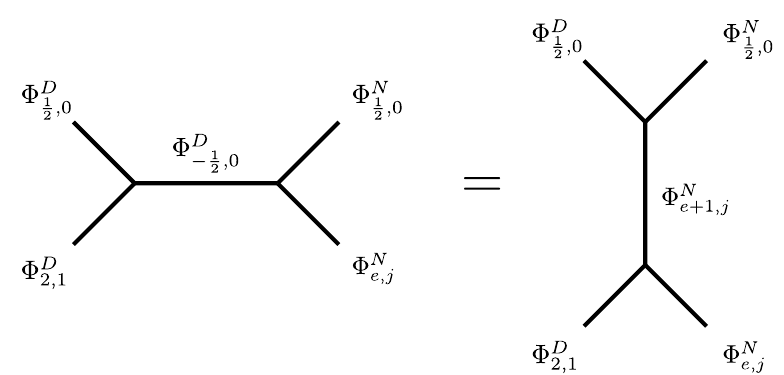
Φ D Φ N Φ N i . Notice that 2 , 1 e,j 1 1 , 0 , 0 2 2 in the t -channel which relates two , 0 ) D ( 1 , 0 ) N 2 2